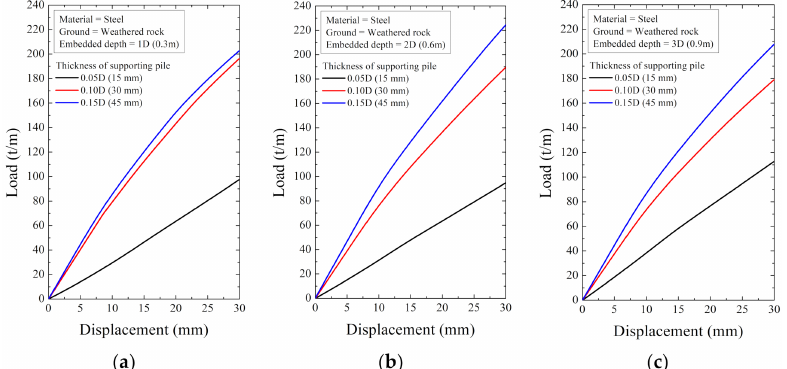
Figure 21. The displacement–load curve when supporting material is steel in weathered rock at embedded depth: ( a ) 1D (0.3 m), ( b ) 2D (0.6 m), and ( c ) 3D (0.9 m).